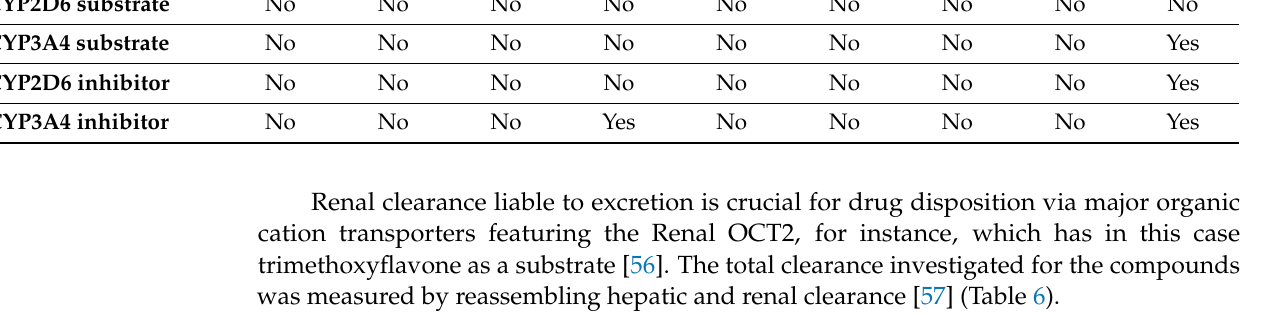
Table 6. Excretion parameter prediction of AHEE. ( 1 ) Gallic acid, ( 2 ) syringic acid, ( 3 ) trans - ferulic acid, ( 4 ) myricetin, ( 5 ) catechin gallate, ( 6 ) caffeic acid, ( 7 ) chlorogenic acid, ( 8 ) arbutin,